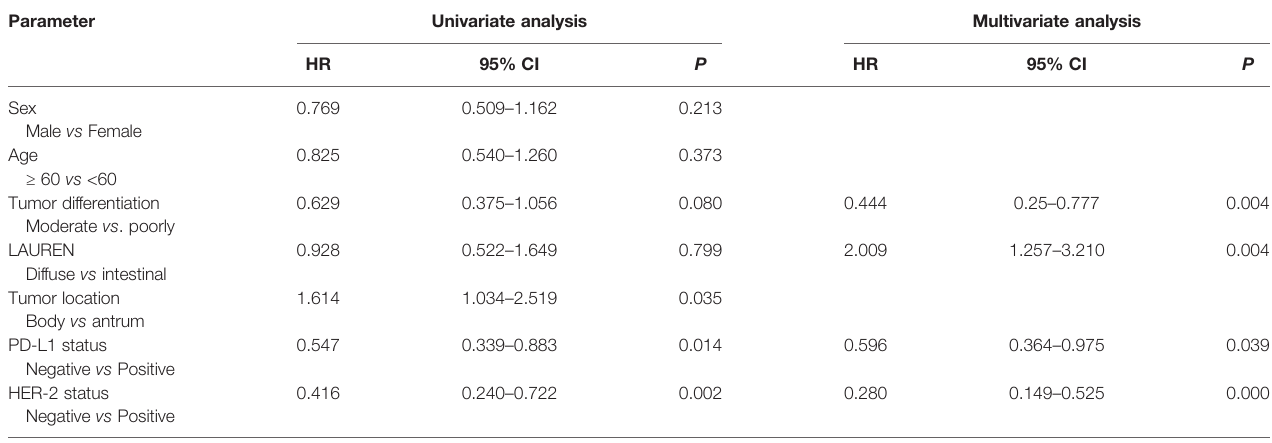
TABLE 2 | Univariate and multivariate analyses of progression-free survival. Parameter Univariate analysis Multivariate